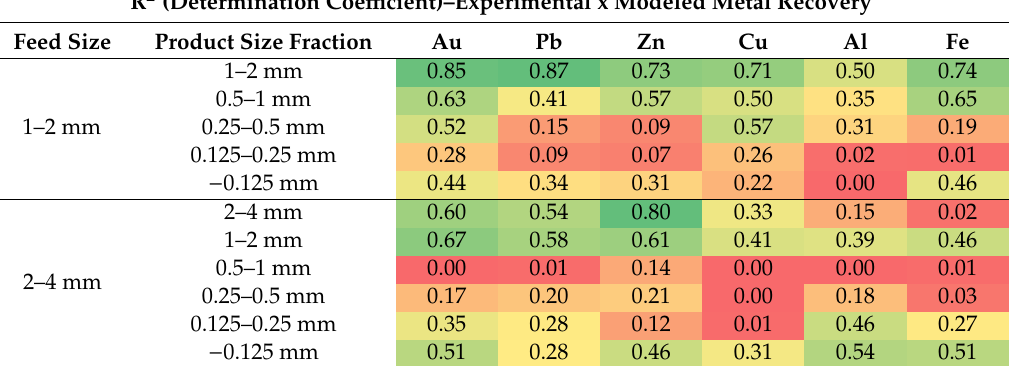
Table 2. Coefficient of determination (R²) obtained from the linear regression analyses between experimental and modeled calculation of the metal recovery.